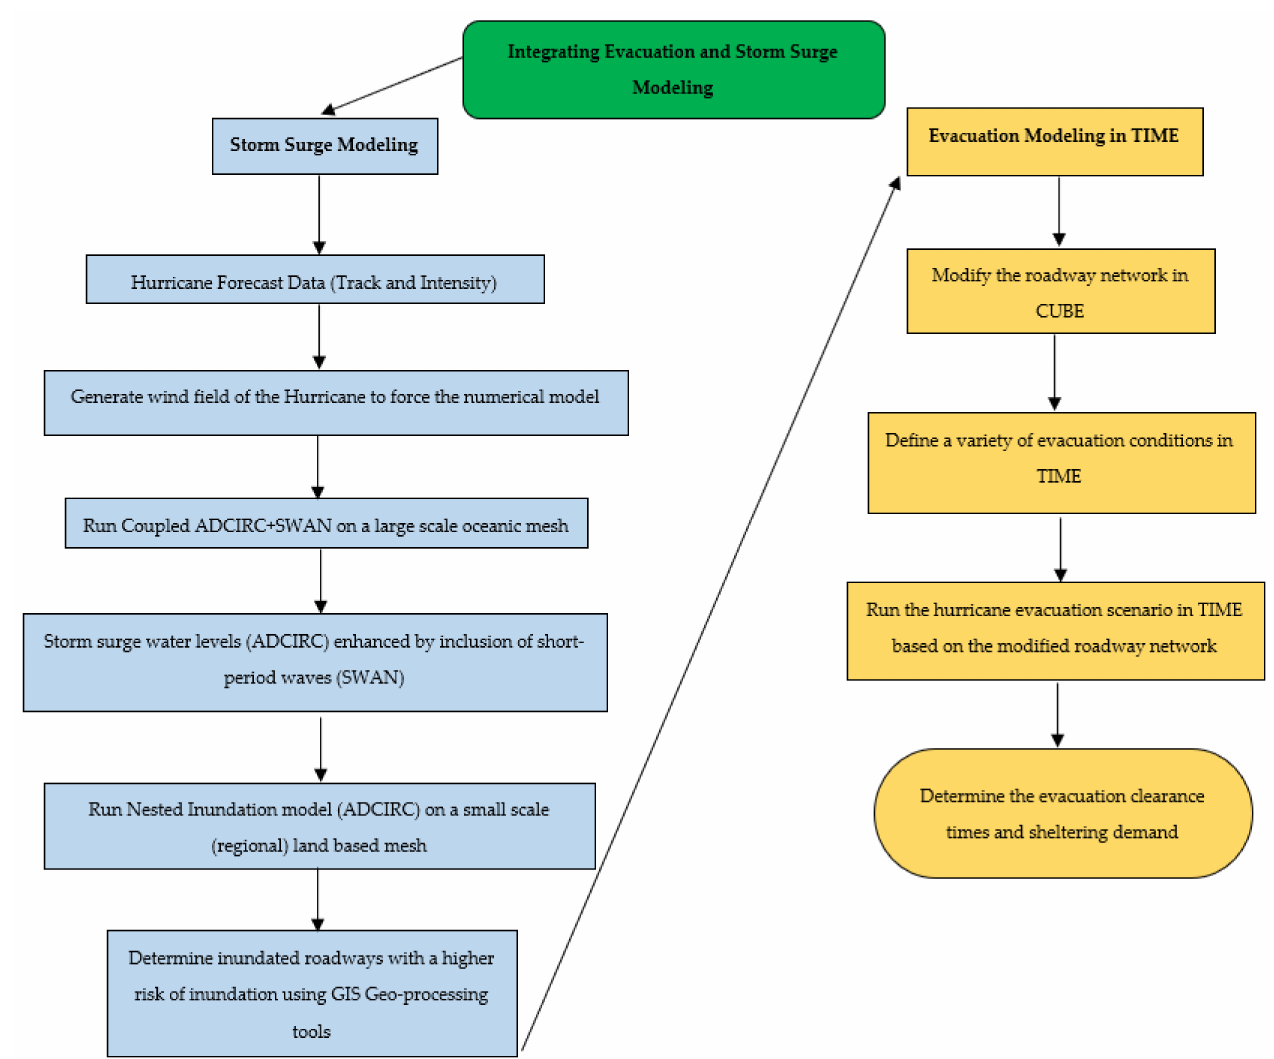
Figure 3. Methodology conceptual